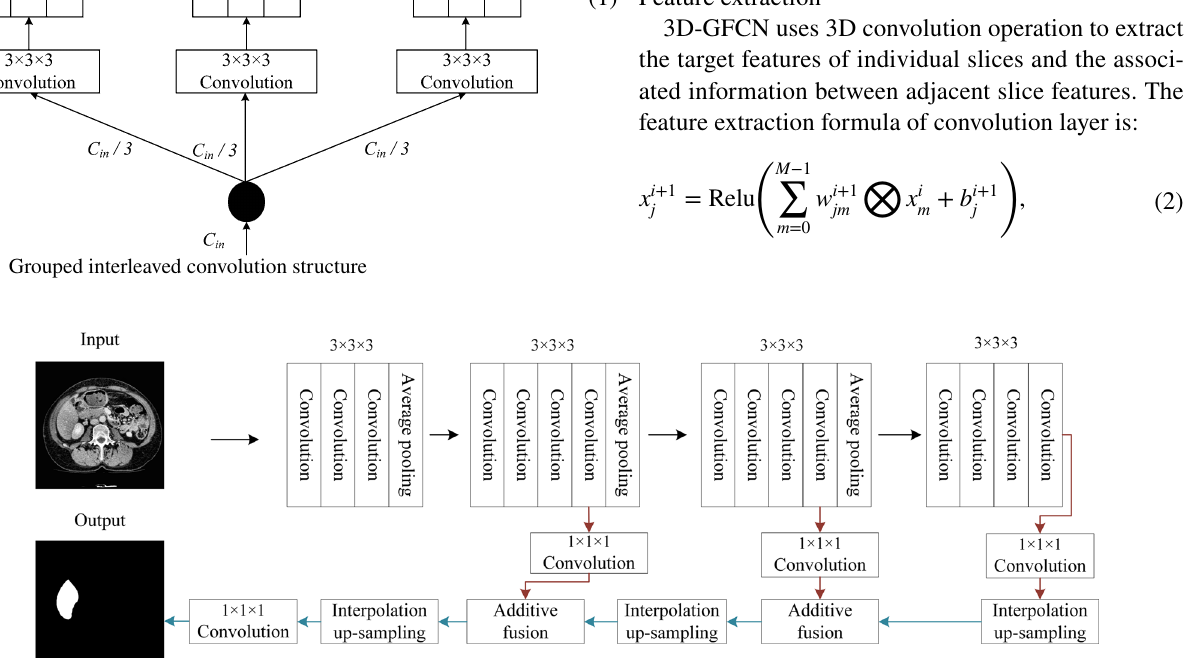
Fig. 4 3D grouped fully convolutional neural network